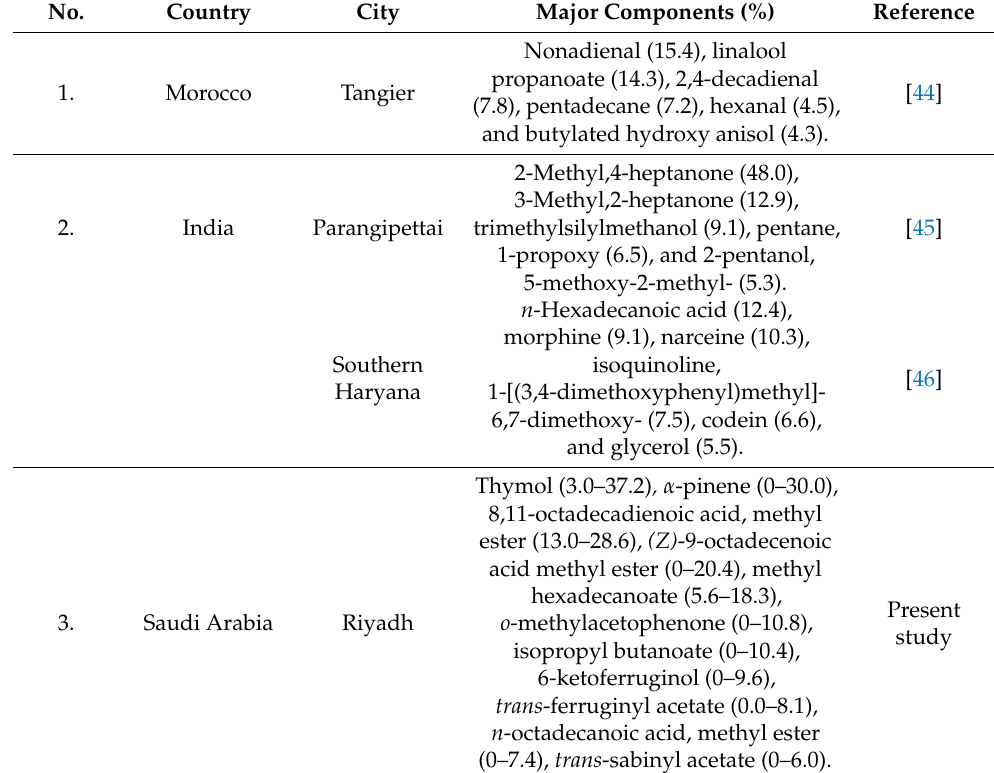
Figure 3. Chemical structure of most dominating identified compounds from C. colocynthis seeds extracts. Table 2. Major components of C. colocynthis from different parts of the world.